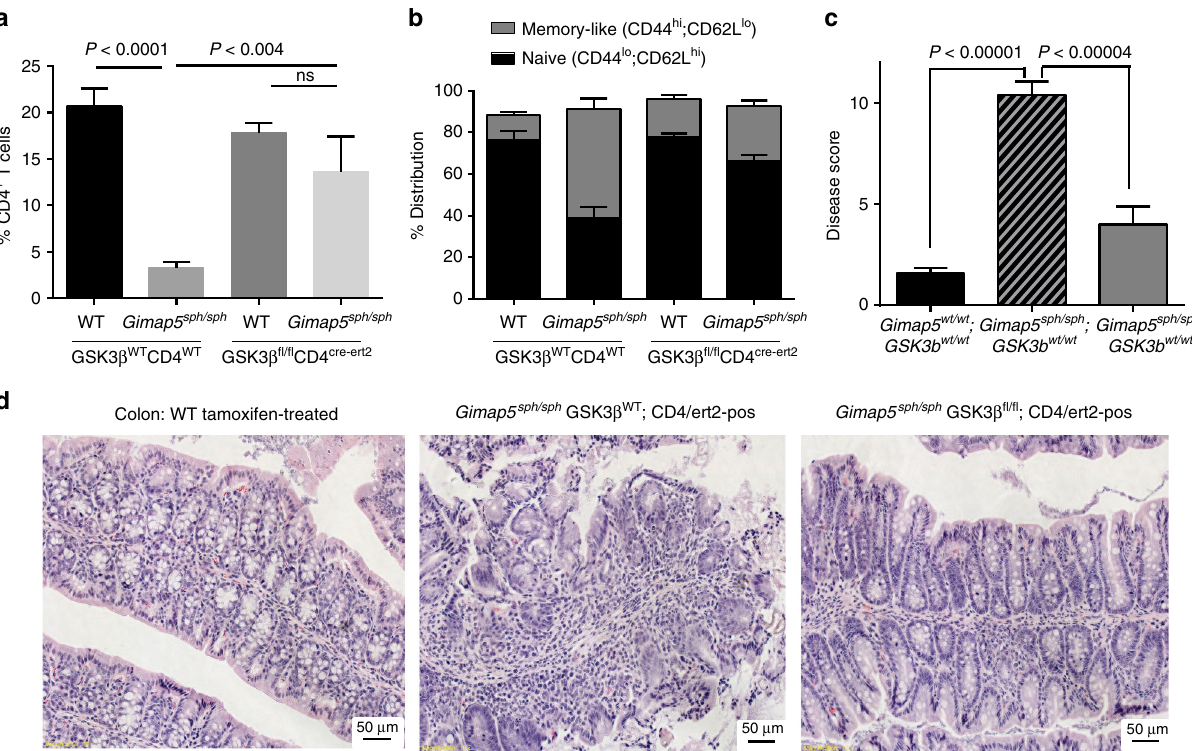
Fig. 6 GSK3 β deletion in CD4 + T cells improves CD4 + T cell survival and prevents colitis. a Tamoxifen treatment of Gimap5 sph/sph ; Gsk3b fl / fl ; Cd4cre-ert2 mice starting at 3 weeks of age selectively rescues splenic CD4 + T cell survival, b while maintaining overall CD4 + T cell quiescence. Reduced colitis in Gimap5 sph/sph ; Gsk3b fl / fl ; Cd4cre-ert2 mice treated with tamoxifen as determined by disease scores ( c ) based on histology ( d ). Data represent mean values ± SEM from at least 6 mice per group at 8 weeks of age; histology is a representative depiction of disease severity. Scale bar is 50 μ m. Statistical signi fi cance is determined by ANOVA followed by Sidak ’ s multiple comparisons